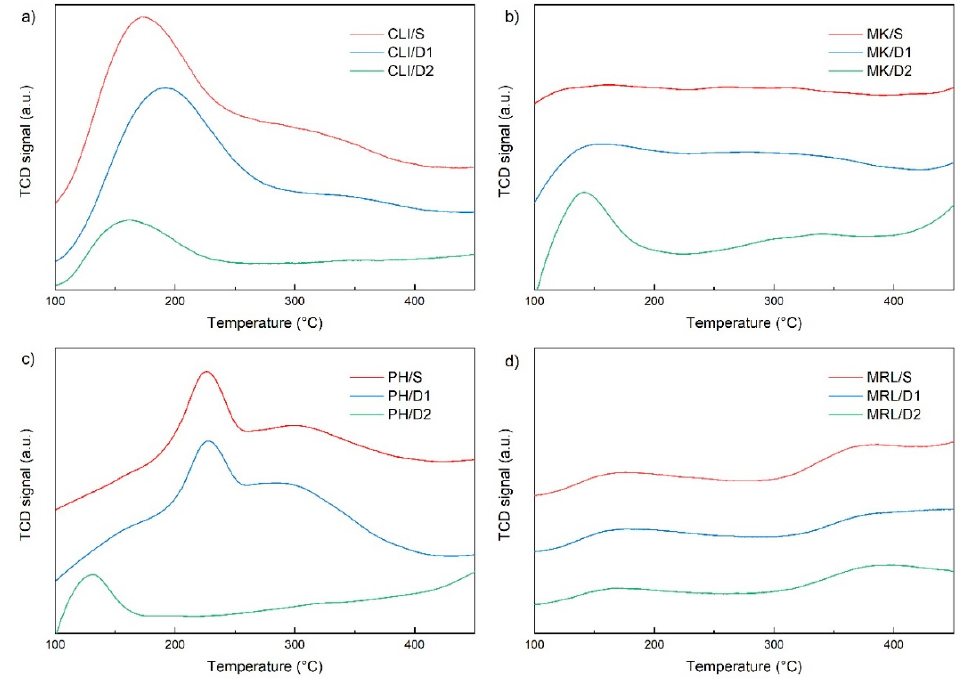
Figure 5. NH 3 -TPD of clinoptilolite ( a ), metakaolin ( b ), phonolite ( c ) and marlstone ( d ) .